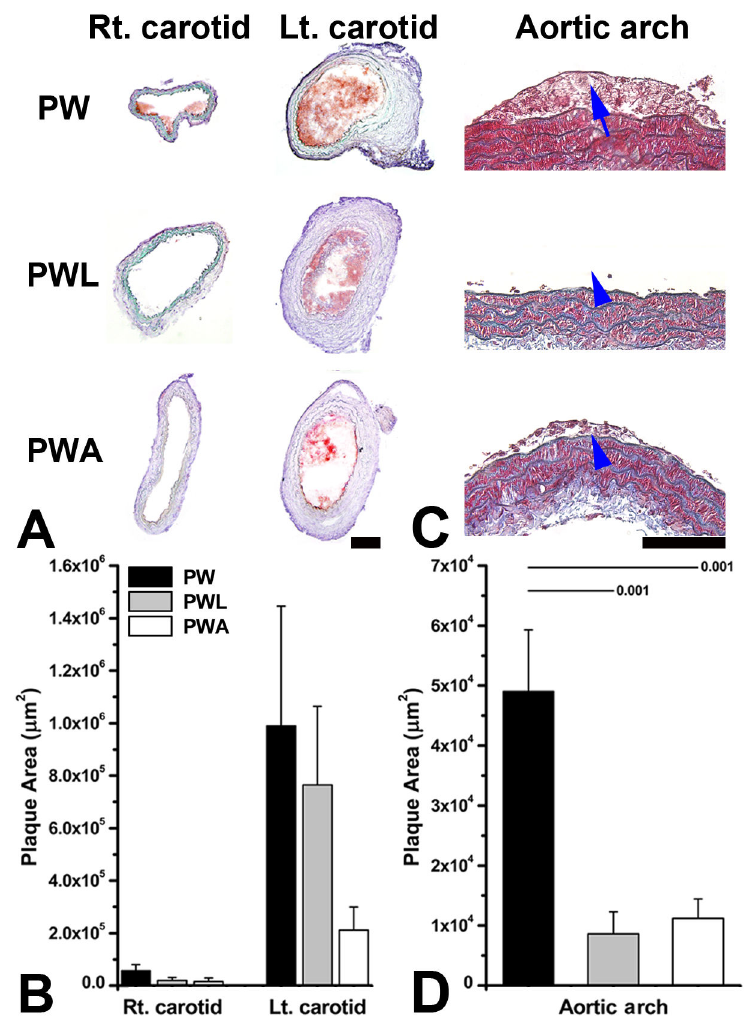
Figure 4. LiCl or atorvastatin to decrease plaque size significantly in the aortic arch, but not in the ligated area of the left common carotid artery (CCA). Two weeks after partial ligation of the left CCA, carotid plaque size (oil red O-stained red area) was non-significantly smaller in the representative ApoE -/- mouse fed on a western diet with LiCl (PWL) or atorvastatin (PWA) treatment vs. the animal without treatment (PW) (A). This is corroborated by the quantitative data (B). In the aortic arch (C, Masson’s trichrome staining), plaque size is significantly smaller in the treated animals (blue arrow-heads) than in the control (blue arrow). Quantitative data (D) again corroborate the findings. Statistically significant p values from Mann-Whitney tests are provided. Scale-bars, 100